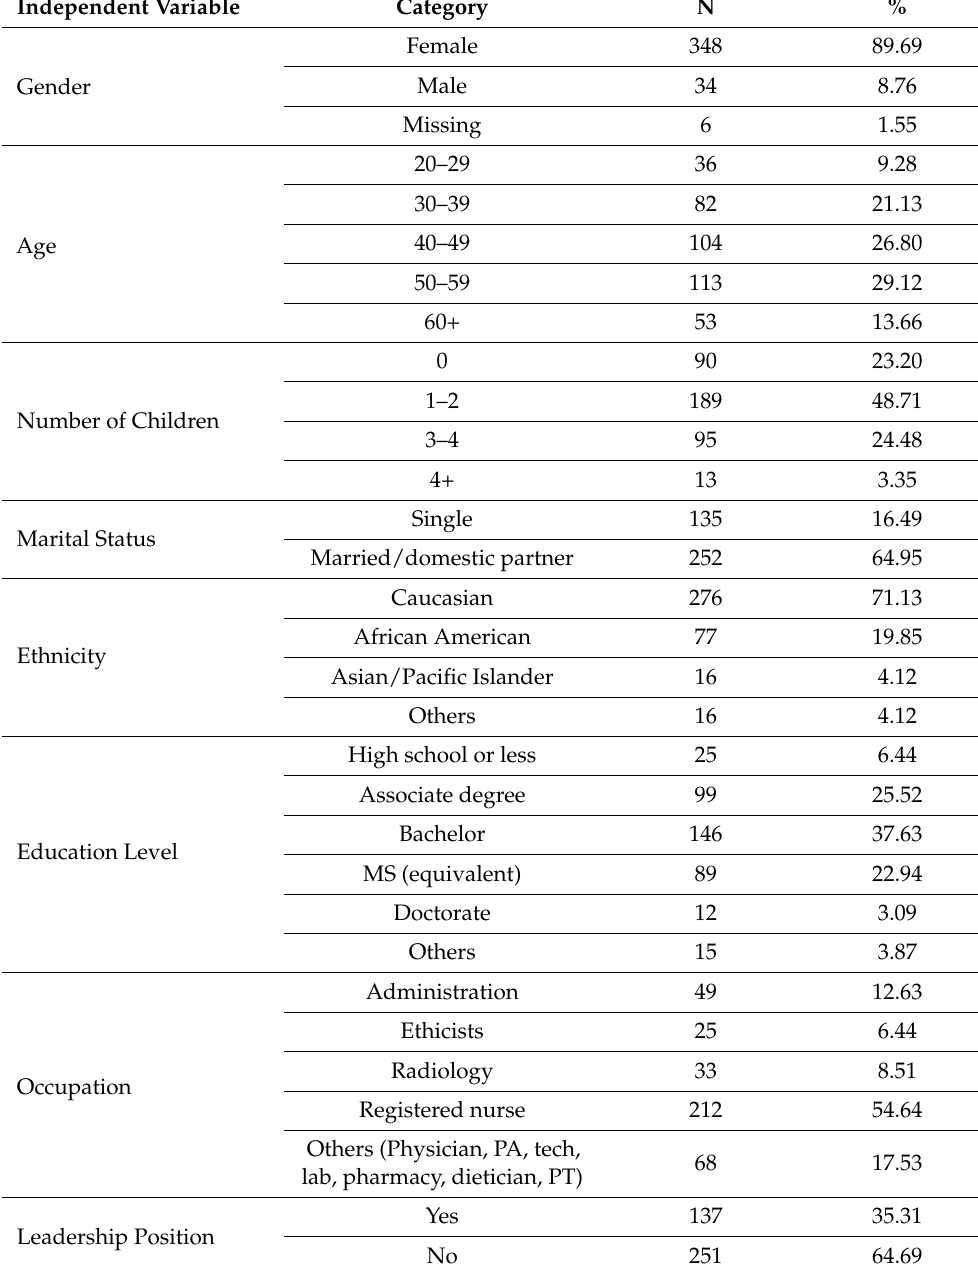
Table 1. Demographic